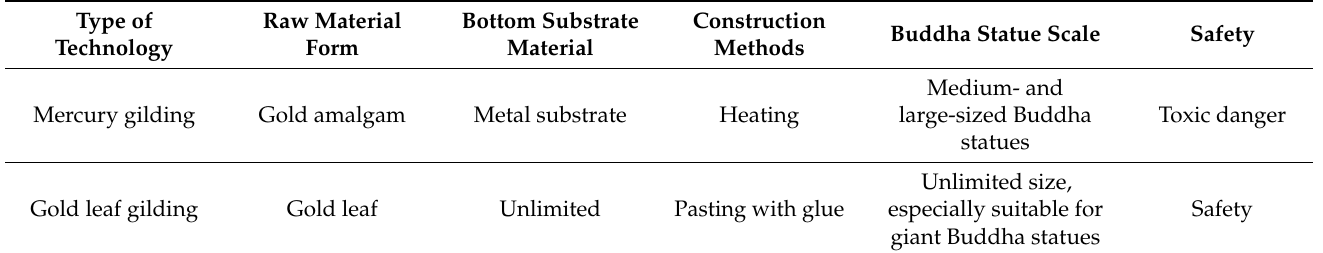
Table 1. Comparison of mercury bronzing and gold leaf bronzing techniques used in the surface treatment of Buddha